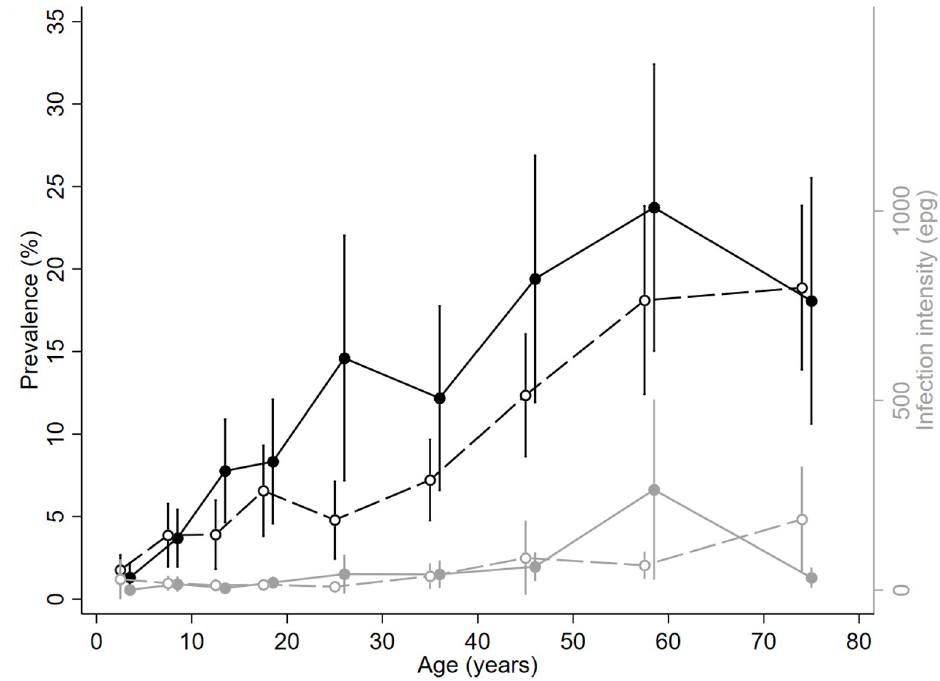
Fig 4. Hookworm age-sex-infection profiles. Prevalence (black) and intensity (grey) of hookworm infection by age (years) and sex (males= solid line and circles, females= dashed lines and empty circles).